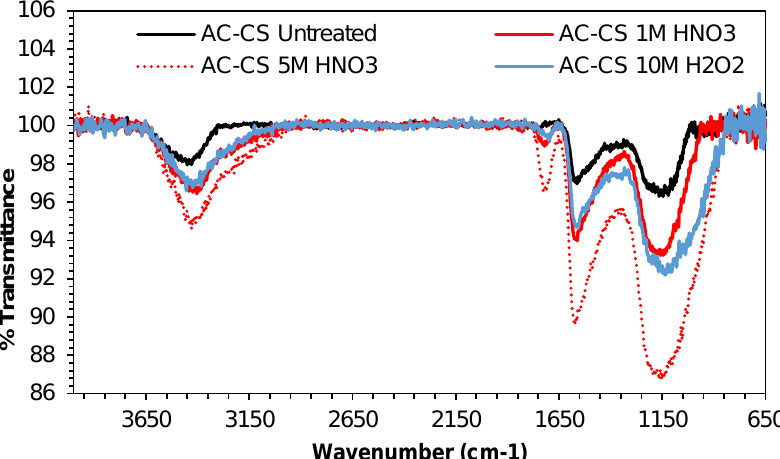
Figure 5. FTIR Spectra for AC-CS (coconut shell-based) untreated, nitric treated, and peroxide treated.